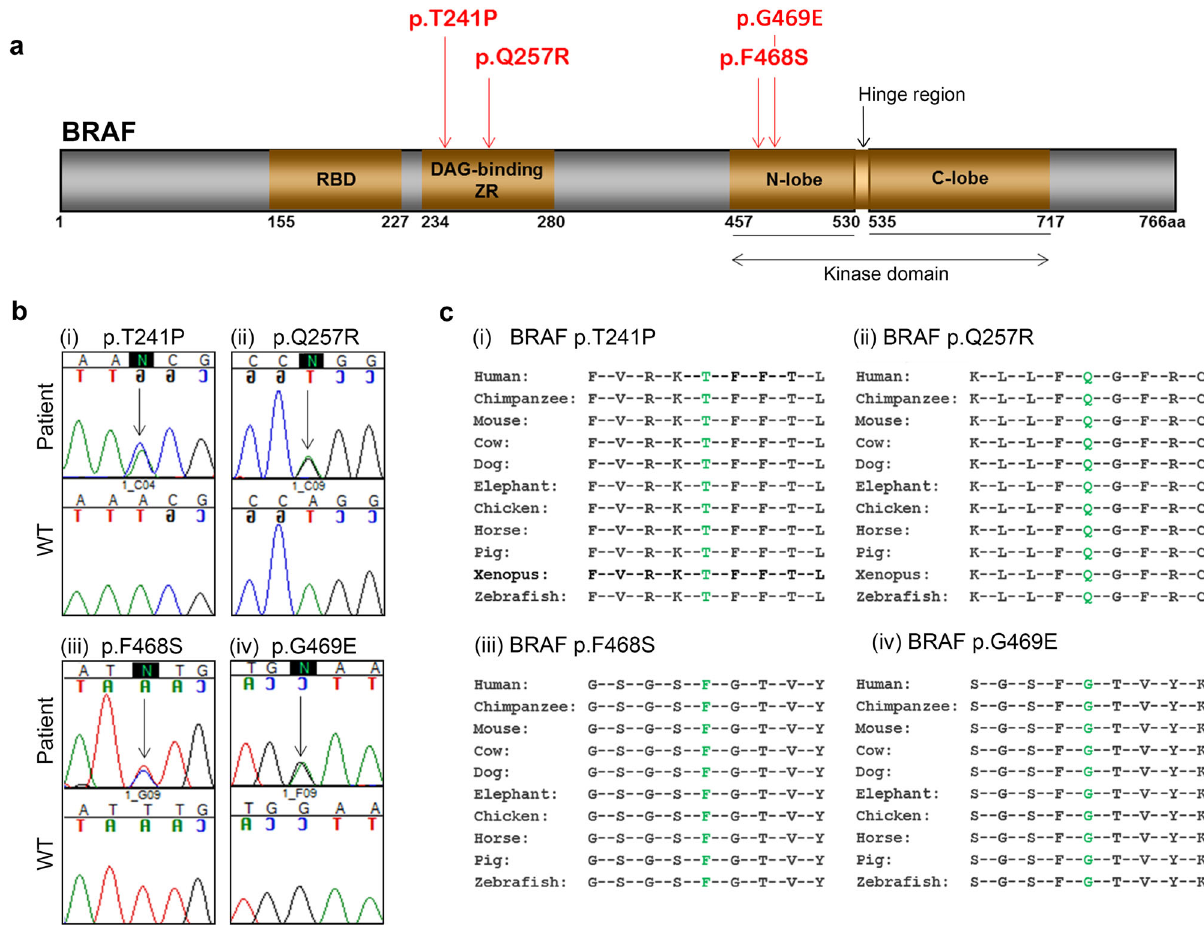
Fig. 1 Mutations identi fi ed in hBRAF in patients with CFC and SOD. a Schematic diagram of the hBRAF protein and the location of the mutations identi fi ed. The numbers indicate the location where each protein domain begins and ends. The mutations identi fi ed in the patients are labelled indicating the position of the substitution. b Electropherograms illustrating the mutations identi fi ed, indicated by an arrow and an ‘ N ’ in the sequence of each patient, with the corresponding wild-type (Wt) sequence below. (i) A heterozygous missense variant (c.721A>C) was identi fi ed in exon 6 of BRAF in patient 3, (ii) a heterozygous missense variant (c.770A>G) was identi fi ed in exon 6 of BRAF in patients 1 and 4, (iii) a heterozygous missense variant (c.1403T>C) was identi fi ed in exon 11 of BRAF in patient 2, (iv) a heterozygous missense variant (c.1406G>A) was identi fi ed in exon 11 of BRAF in patient 5. c Amino acid conservation of the BRAF substitutions identi fi ed in our study. (i) The threonine residue (represented by the green ‘ T ’ ) at position p.T241, (ii) the glutamine (represented by the green ‘ Q ’ ) at position p.Q257, (iii) the phenylalanine (represented by the green ‘ F ’ ) at position p.F468 and (iv) the glycine (represented by the green ‘ G ’ ) at position p.G469, and their adjacent protein sequences either side, respectively, are located at conserved regions across